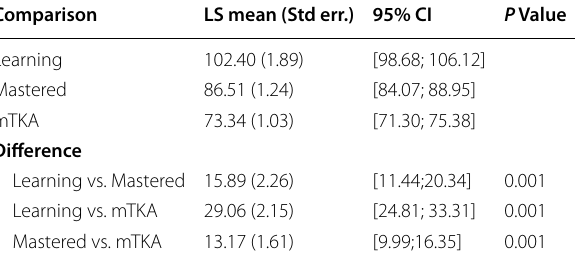
Table 3 Total operative time (minutes) between the learning raTKA, mastered raTKA, and mTKA groups. Reported as least square (LS) mean and standard error